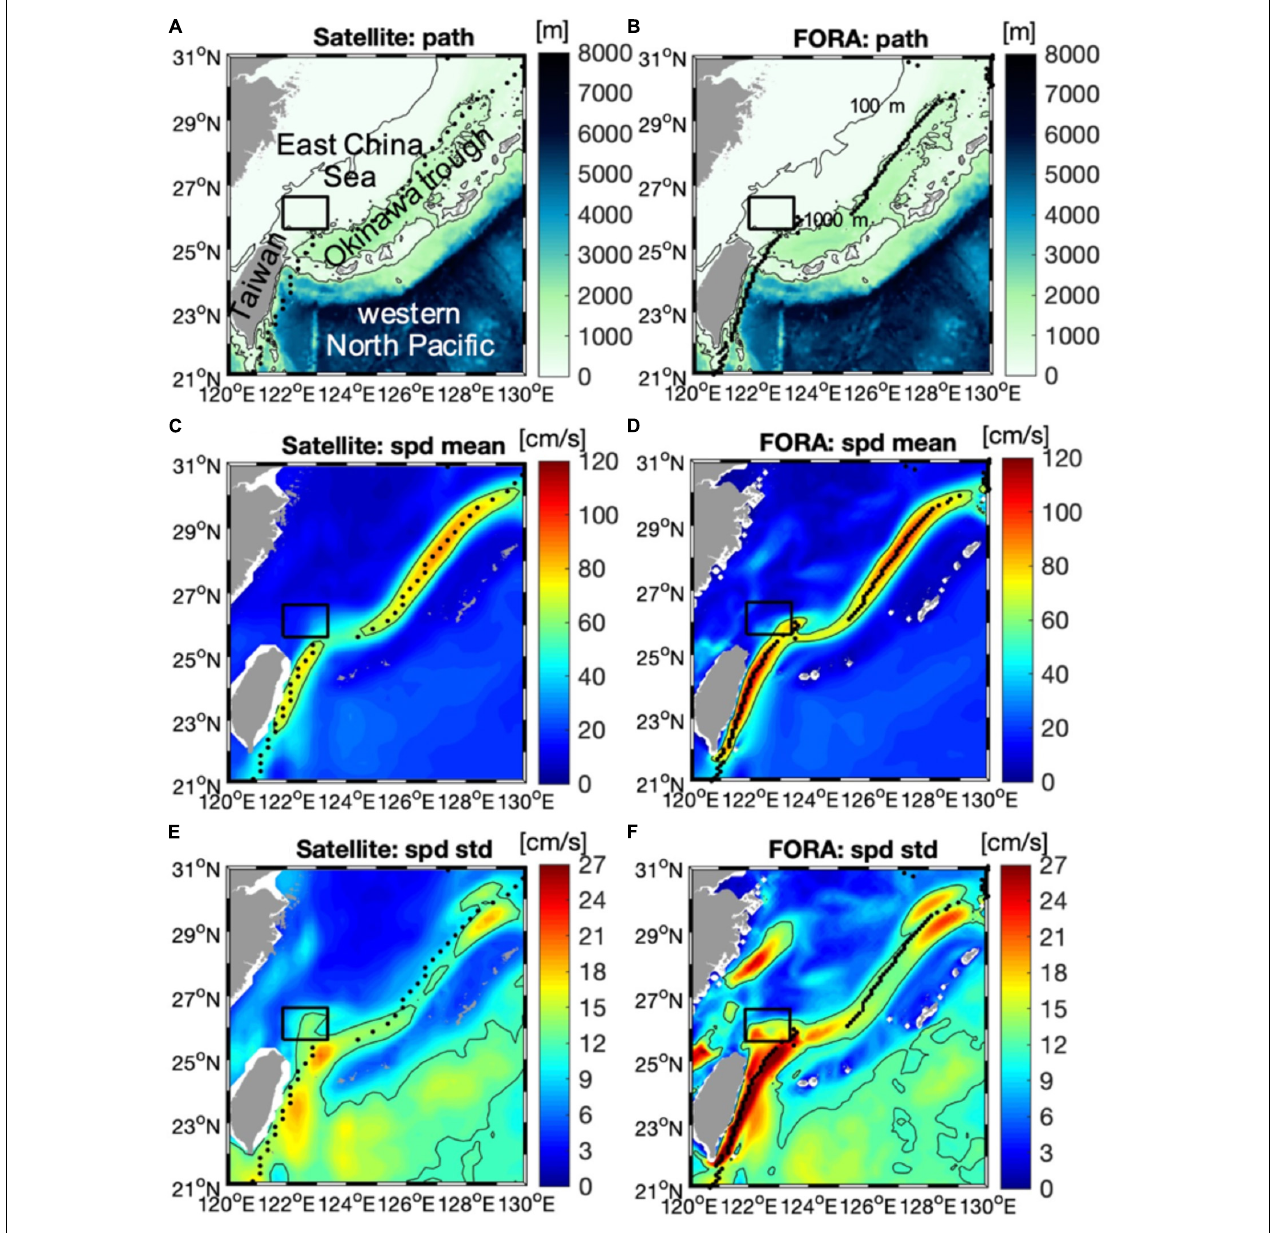
FIGURE 1 | (A,B) Bathymetry from ETOPO2 and the mean path of the Kuroshio; (C,D) mean and (E,F) standard deviation of the surface current speed from monthly mean satellite altimetry for 1993–2018 ( left ) and monthly mean FORA for 1993–2014 ( right ). Black contours in panels (A,B) denote 100 and 1,000 m isobaths. The mean path of the Kuroshio, derived by longitudinal positions of maximum current speed at each latitude grid, is displayed as black dots. Black squares denote the Kuroshio shelf intrusion (KSI) domain, and black contours in panels (C–F) denote the 60 cm/s mean speed and the 12 cm/s standard deviation, respectively.